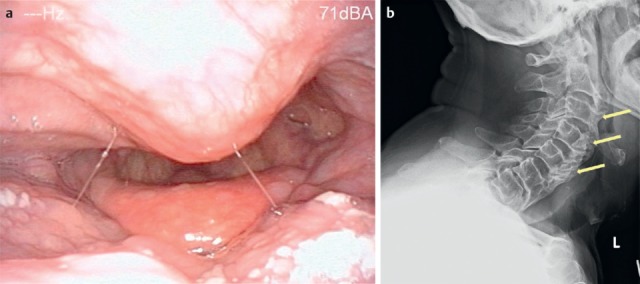
Forestier’s disease in a 75-year-old female patient. Dysphagia because of prominent hyperostosis of the cervical spine: a – endoscopically, a clear midline protrusion of the posterior pharyngeal wall is visible with relation to the base of tongue and epiglottis; b – lateral radiography of the cervical spine of the same patient with visible bony attachments to the vertebrae and ligamentous structures (C2–6, see arrows).